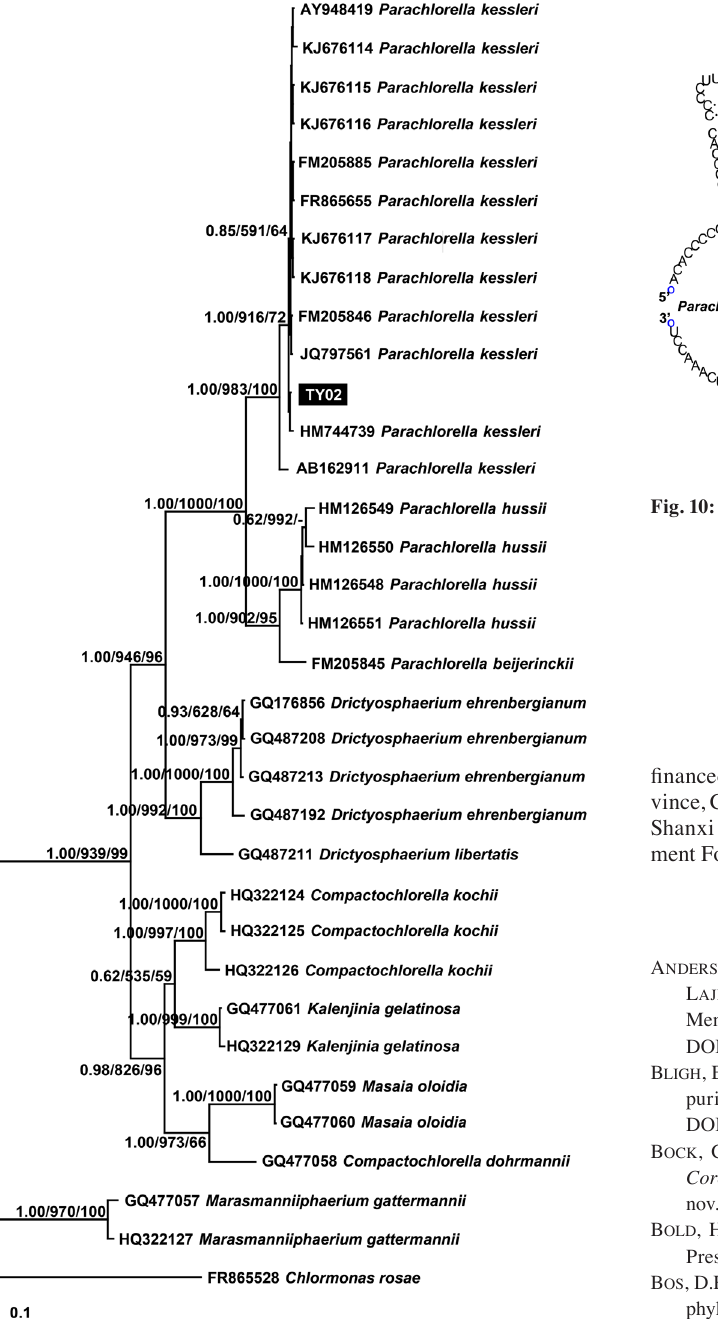
Fig. 9: Bayesian analysis tree based on ITS gene sequences. The numerical values at the nodes represent the support values of BI bootstrap/ML bootstrap/NJ bootstrap. Values <50% are not